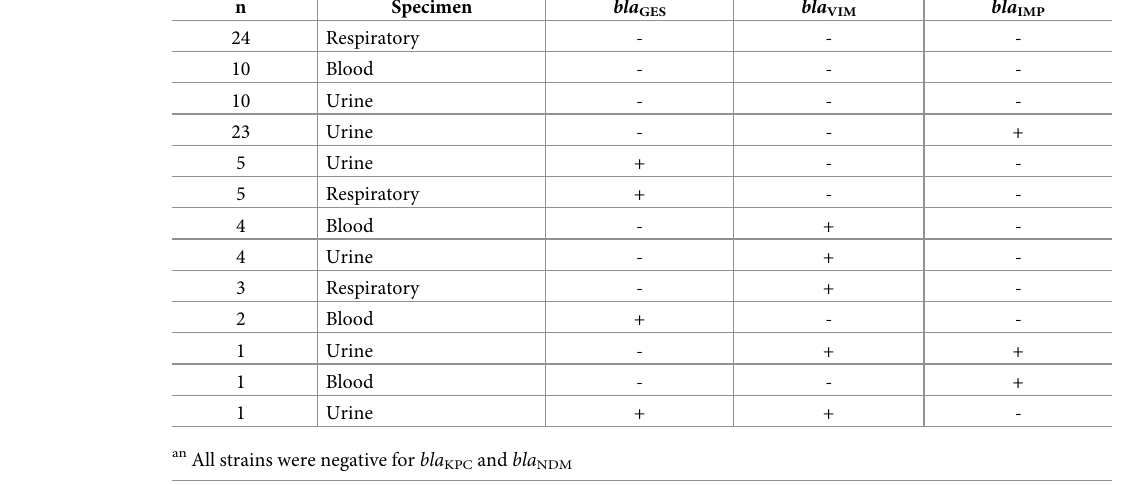
Table 8. Distribution of carbapenemase-encoding genes among P . aeruginosa carbapenem-resistant clinical iso- lates �